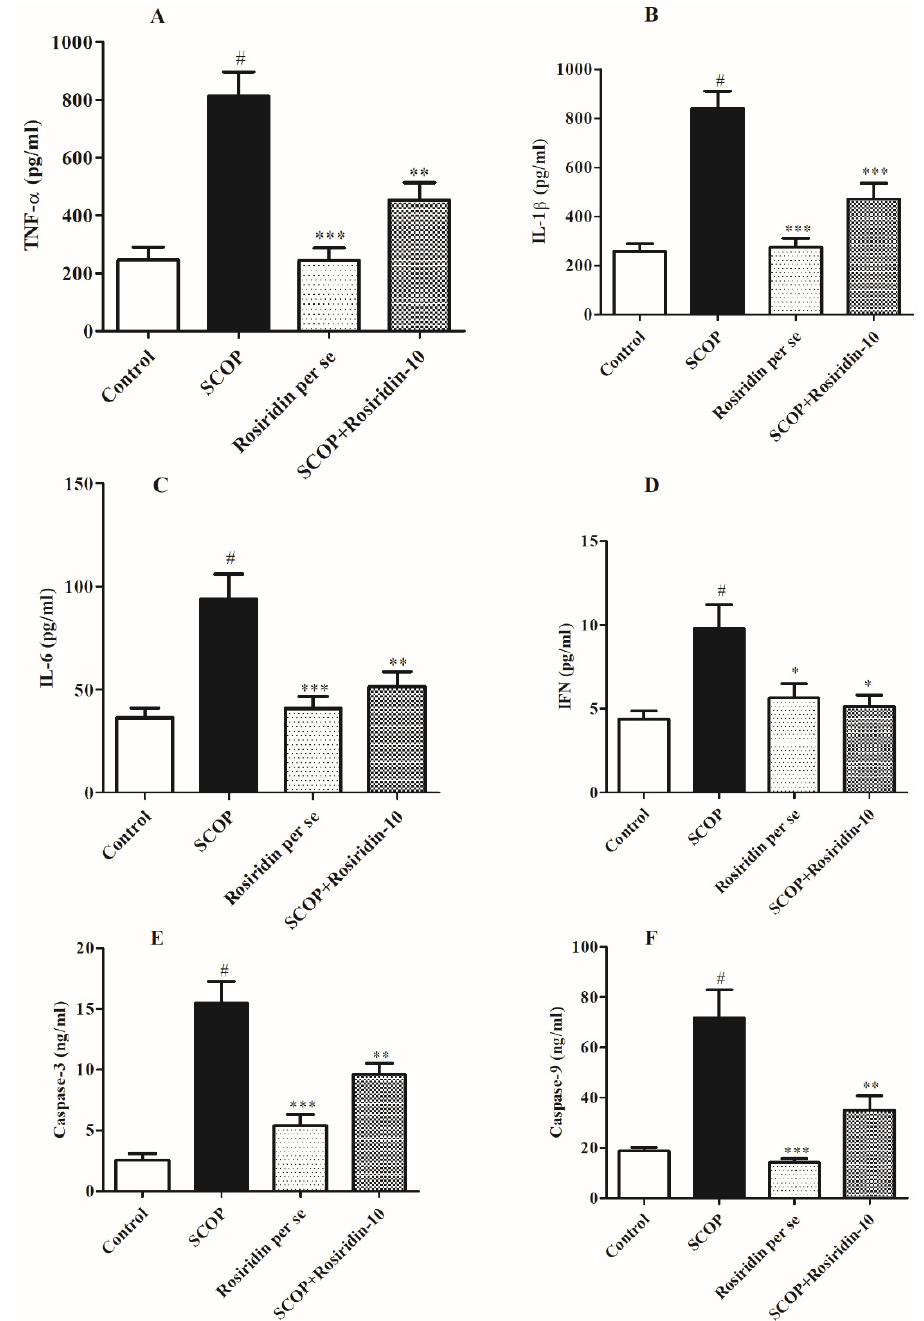
Figure 7. Graphs illustrating the influence of rosiridin on ( A ) TNF- α , ( B ) IL-1 β , ( C ) IL-6, ( D ) IFN ( E ) caspase 3, and ( F ) caspase 9. Mean ± S.E.M. ( n = 6). # p < 0.001 vs. normal control, *** p < 0.001 vs. scopolamine control, ** p < 0.01 vs. scopolamine control, * p < 0.05 vs. scopolamine control; one-way ANOVA followed by Tukey’s test.